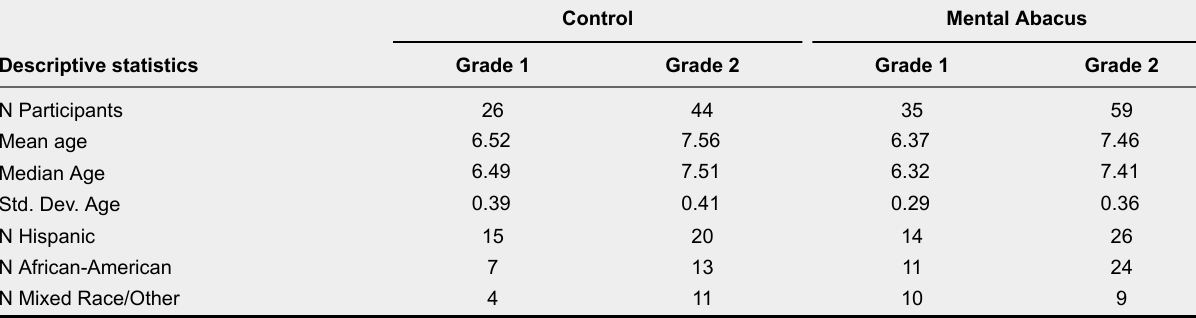
Demographic Description of Participant